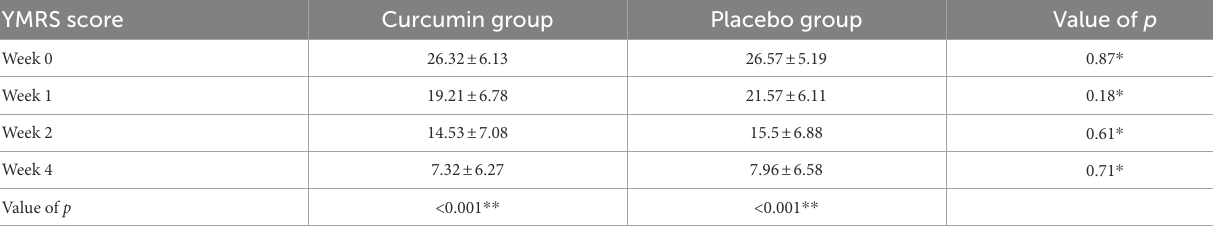
Dependent t -test. ** Repeated measure.